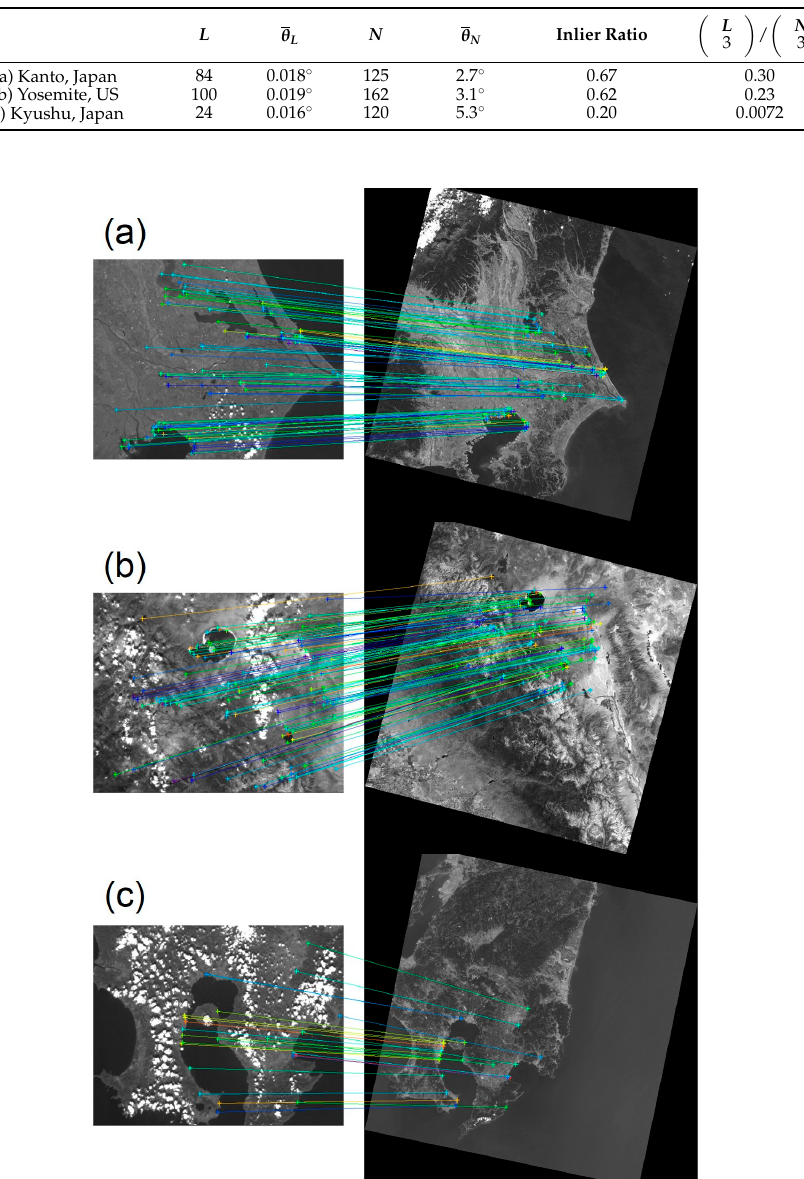
Figure 5. Feature matching results of the images of ( a ) the less cloudy (Kanto, Japan), ( b ) the moderately cloudy (Yosemite, US), and ( c ) the many cloud-patch (Kyushu, Japan) cases as shown in Figure 4, after RANSAC. Line colors represent the similarities as described in Figure 4.